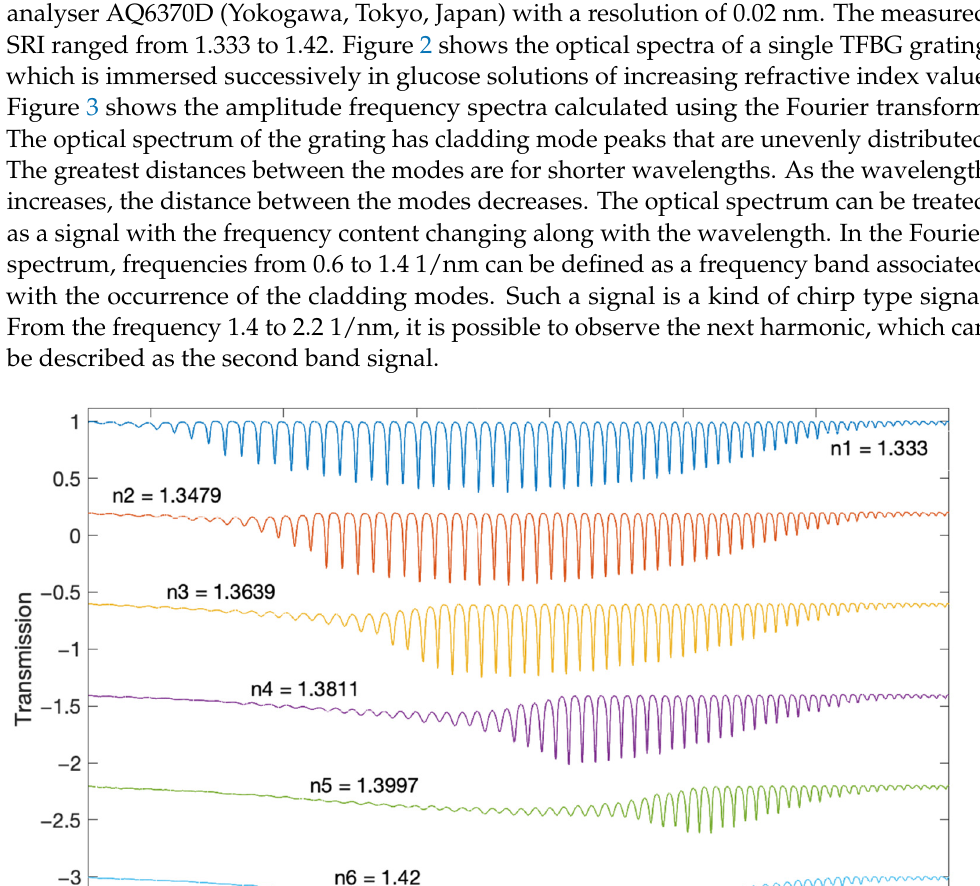
Figure 3. The amplitude Fourier spectrum corresponding to the optical spectra of the TFBG in Figure 2, depending on the SRI. The Fourier transform allows the frequency analysis of the measured spectra and their filtering by using the inverse transform. The fundamental frequency in the TFBG spectrum is related to the cladding mode resonances, which are distributed unevenly in the transmission spectrum. The greatest distances in the spectrum are from the side of the shorter wavelengths and therefore it corresponds to the lowest frequency in the Fourier spectrum. For cladding modes closer to the Bragg and Ghost modes, the distances be- tween the modes are smaller, which corresponds to a higher Fourier frequency. Increasing the SRI causes the smallest frequencies to disappear. The parameter that represents the change in the frequency content of the spectrum, and thus indirectly also the SRI, is the centroid frequency [29].